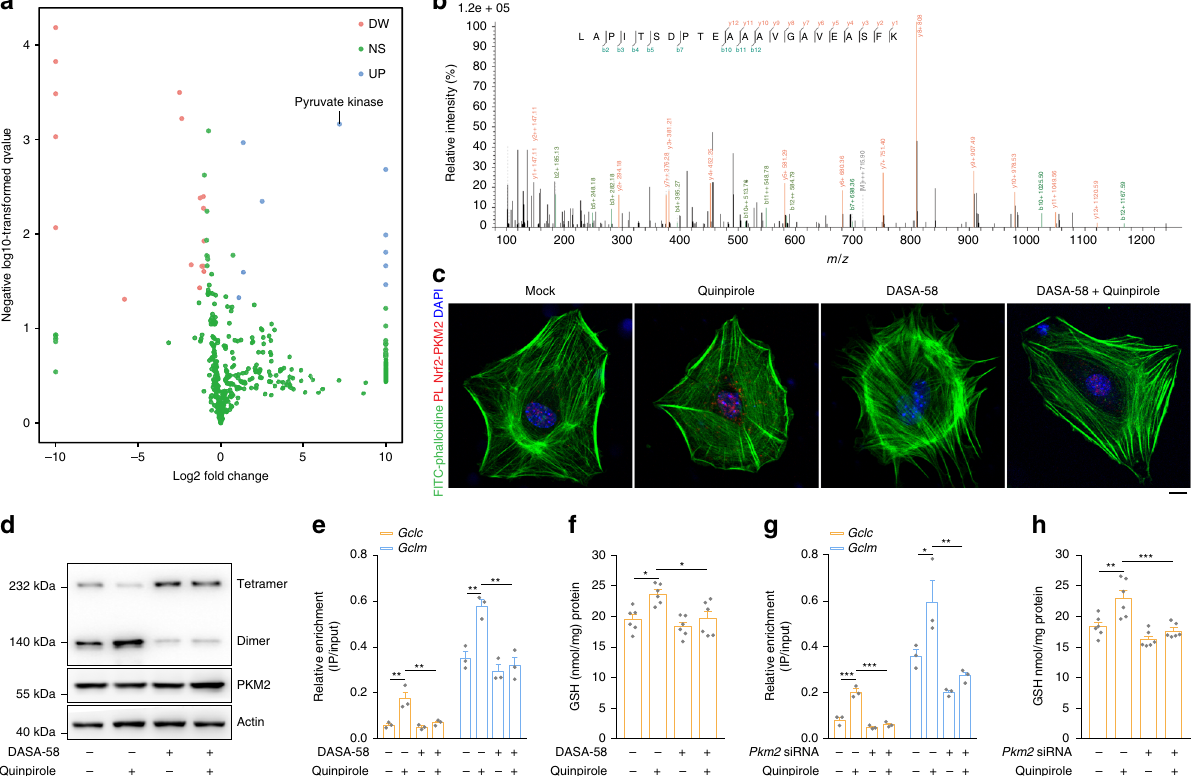
Fig. 2 DRD2 induces PKM2 dimerization to bind with and activate Nrf2. a Volcano plot of label-free mass spectrometry-quanti fi ed proteins that bound Nrf2 with a signi fi cant fold change after DRD2 activation. Only proteins identi fi ed in at least two or three replicates with a fold change > 2.0 and a p -value < 0.05 were regarded signi fi cantly changed. b Representative fragmentation spectrum of 401 LAPITSDPTEATAVGAVEASFK 422 in PKM2. c – f Primary astrocytes were pretreated with 50 µ M DASA-58 for 1 h and then stimulated with 10 µ M quinpirole for 12 h. PKM2 and Nrf2 proximity ligation signals ( c ). PKM2 dimer and tetramer formation analyzed by BN-PAGE and total PKM2 detected by immunoblotting with actin as a loading control ( d ). The amount of anti-Nrf2-immunoprecipitated DNA detected by qRT-PCR with primers fl anking the Gclc and Gclm promoter regions ( e ) and GSH levels ( f ). Immunoblotting and qRT-PCR: three independent experiments; GSH assay: six independent experiments. Scale bar, 10 µ m. g , h Primary astrocytes transfected with Pkm2 -speci fi c siRNA were stimulated with 10 µ M quinpirole for 12 h. The amount of anti-Nrf2-immunoprecipitated DNA detected by qRT-PCR with primers fl anking the Gclc and Gclm promoter regions ( g ) and GSH levels ( h ). qRT-PCR: three independent experiments; GSH assay: six independent experiments. Data are presented as the mean ± s.e.m. * P < 0.05, ** P < 0.01, *** P < 0.001. One-way ANOVA with Tukey ’ s multiple comparisons test ( e – h ). Source data are provided as a Source Data fi